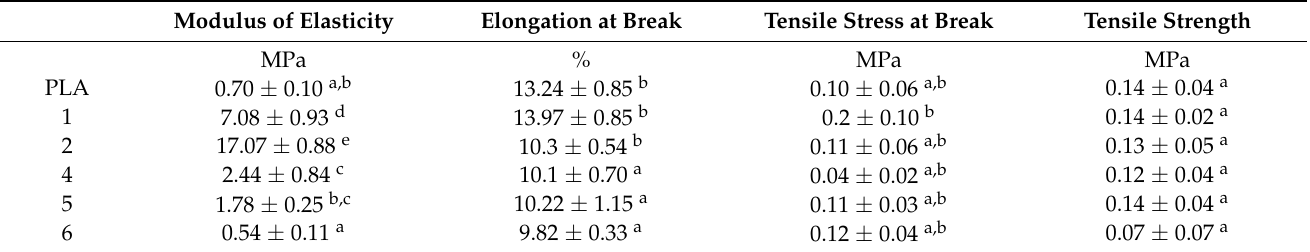
Table 8. Mechanical properties of the pure PLA film and the film added with the assembling ( p < 0.05). Modulus of Elasticity Elongation at Break Tensile Stress at Break Tensile Strength